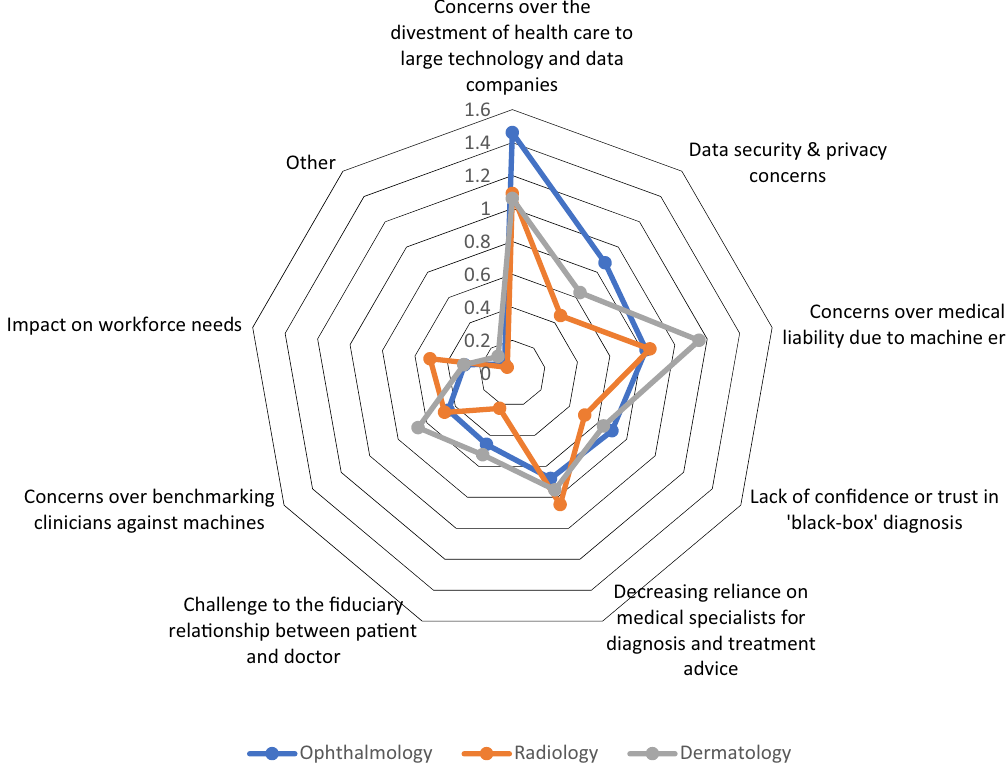
Figure 8. Radar plot showing the highest scoring responses for the perceived concerns or drawbacks of the use of artificial intelligence. Responses were selected from a list of set choices. Plot axes represent the average ranks for all respondents, with higher scores indicating a higher ranking/stronger